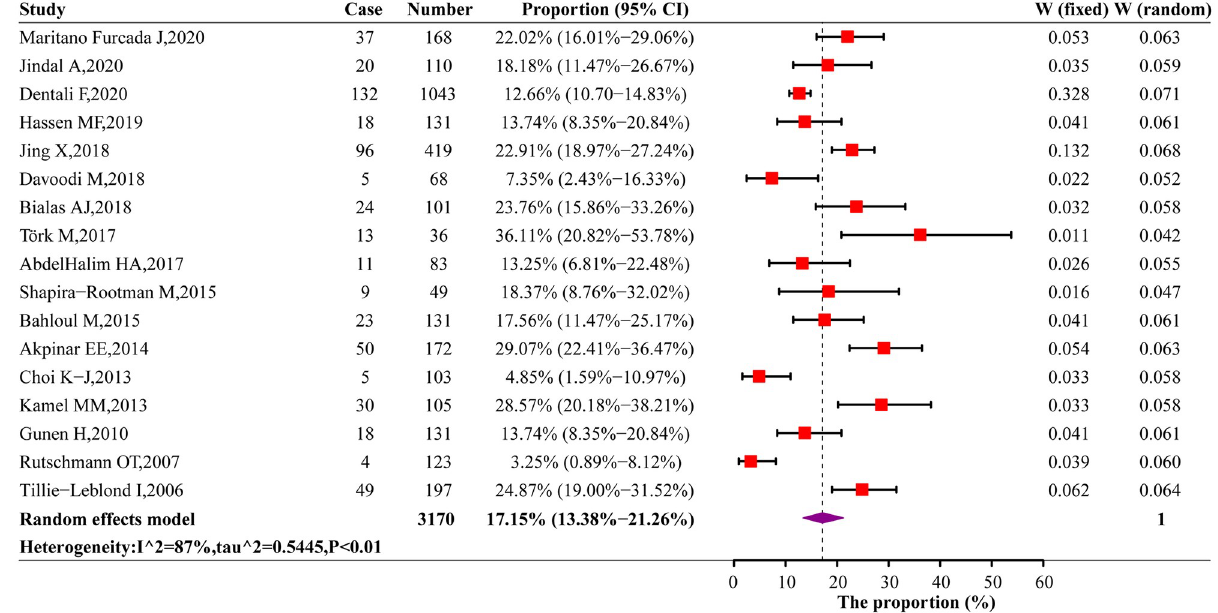
Fig 2. Forest plots of the PE prevalence in AE-COPD patients.